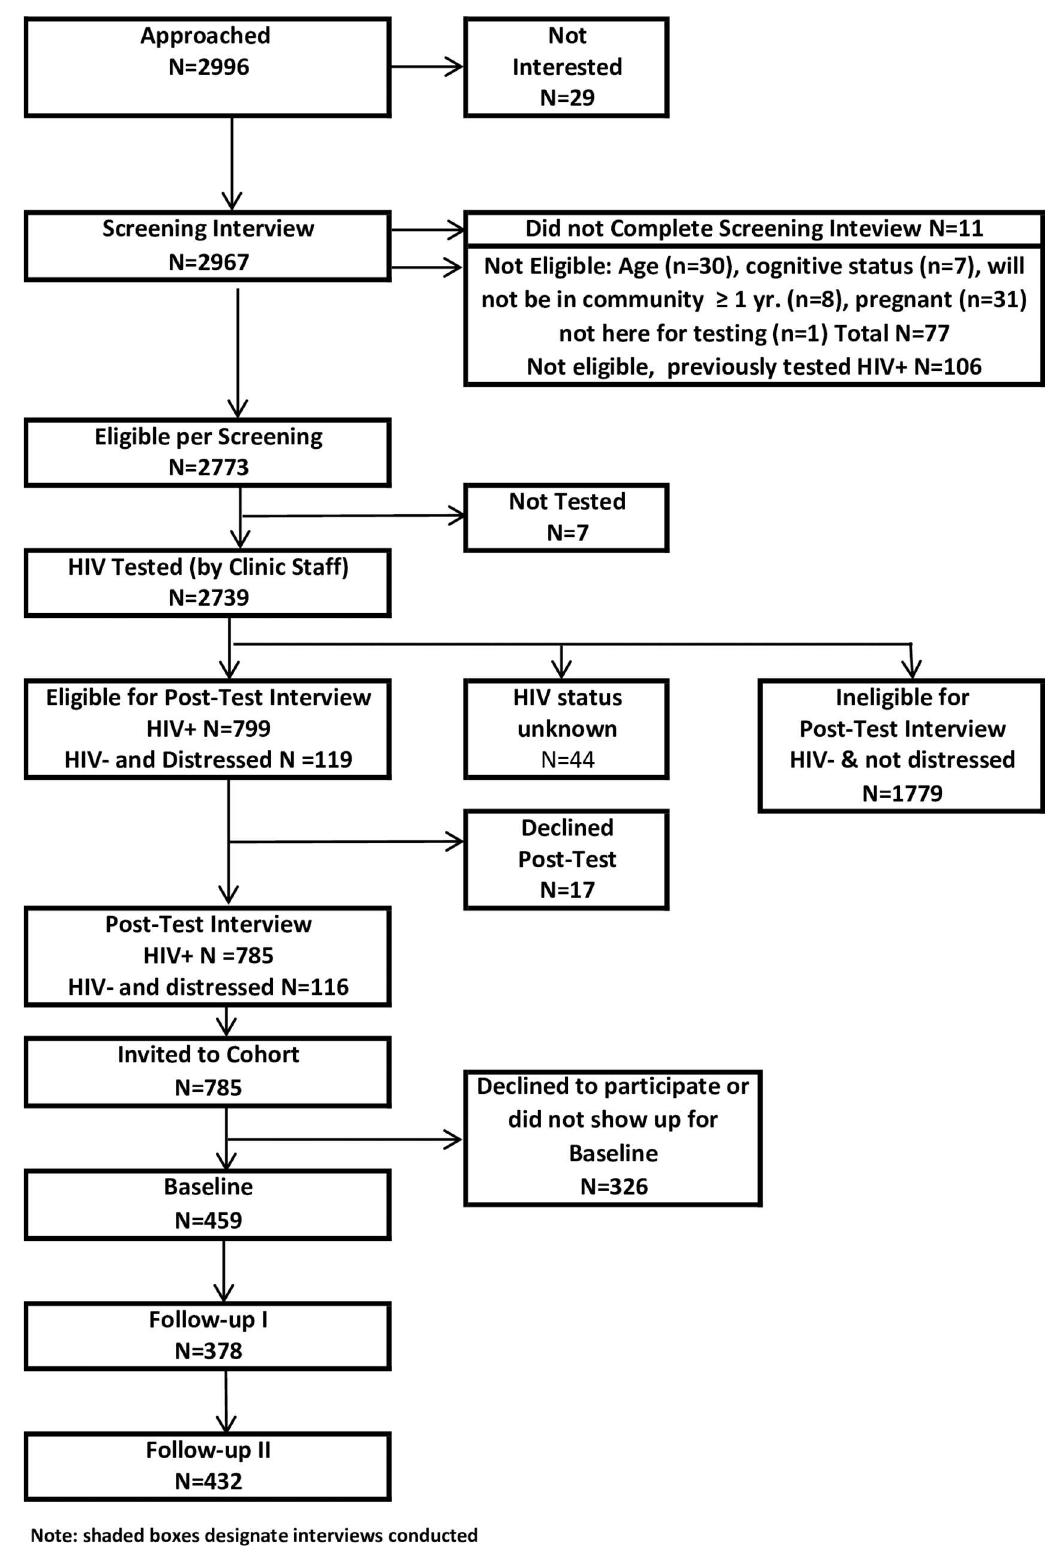
Fig 1. Participant flow for Pathways to Engagement in HIV Care for Newly-Diagnosed South Africans.